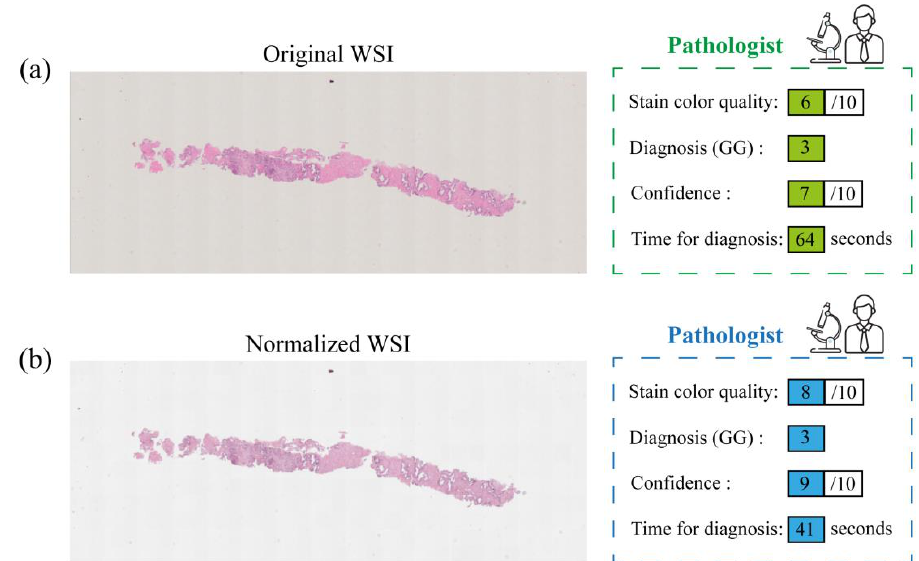
Figure 3. Workflow adopted in this study: an example of original WSI ( a ) and the corresponding normalized slide ( b ) processed by STAINS tool. Both pathologists (P1 and P2) provided evaluations on stain color quality, diagnosis, confidence, and time for diagnosis, for both datasets, i.e., the orig- inal images (an example of pathologist’s evaluation is reported in green) and the corresponding normalized ones (an example of pathologist’s evaluation is reported in blue).